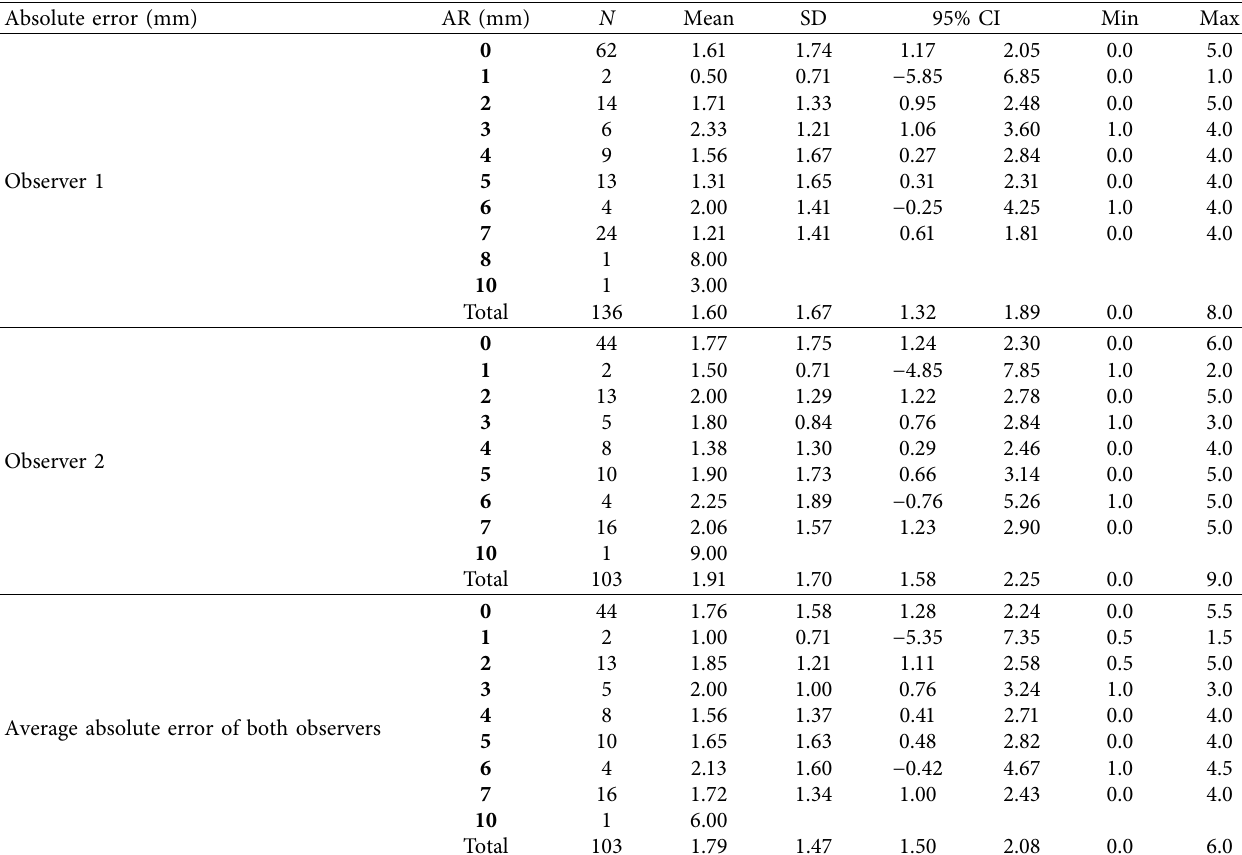
Table 4: Descriptive statistics and 95% CIs for the extents of the directionless absolute error (mm) observed by each of the radiograph assessors in the case of each of the actual resorption extents